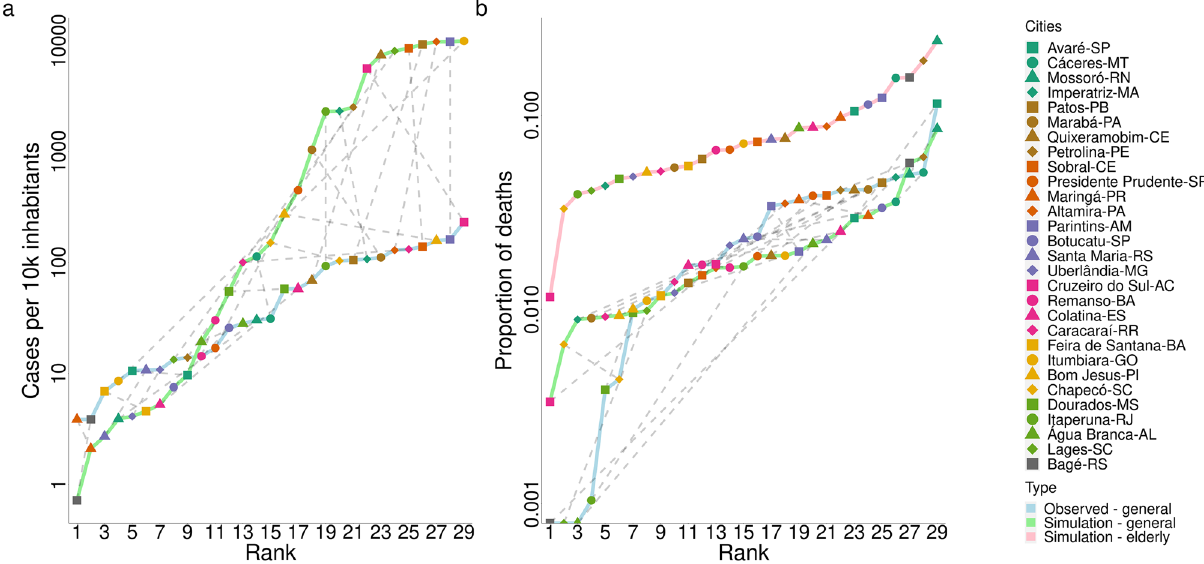
Figure 2. Simulation results and reported data for each municipality on the 60th day of the epidemic. In ( a ), we have the cumulative number of cases per 10,000 inhabitants versus city’s rank from the least infected to the most infected; in ( b ), the proportion of fatal cases versus city’s rank. The sum was done from day 1 to 60 of the epidemic course in each city. The first day was chosen to be the one at which the number of infected cases was higher than 10. The dotted grey lines connect the same city in the observed data and in the simulated data to highlight similarity on both results.